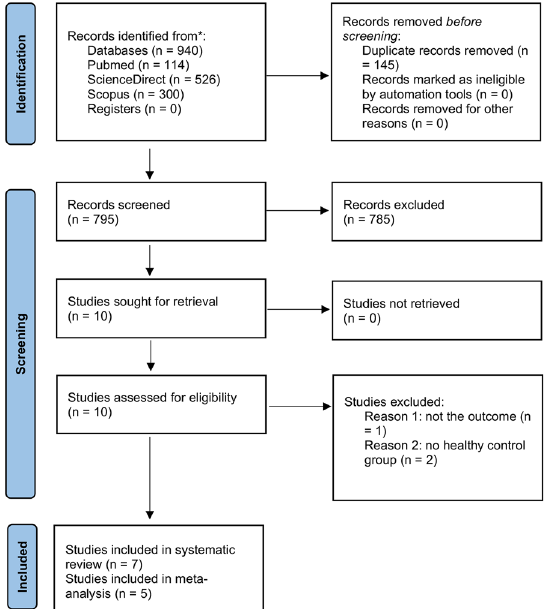
Figure 1. Flowchart of the literature search and screening